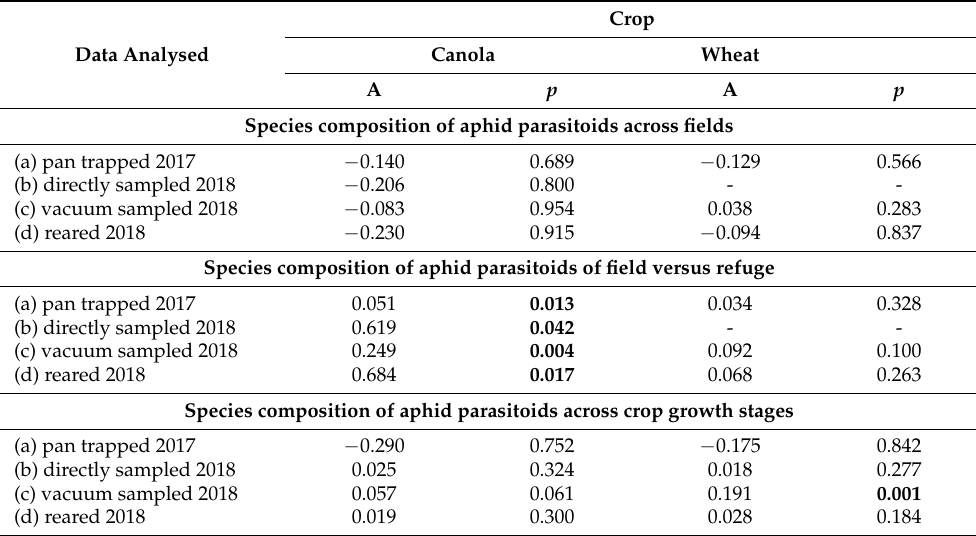
Table 4. Results of MRPP analyses (A statistic, probability) on aphid parasitoid species composition. Crop Canola Wheat Data Analysed A